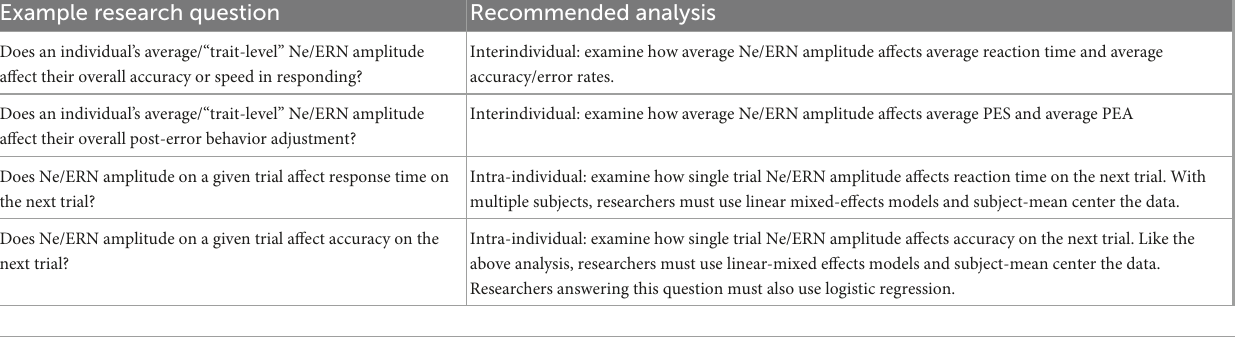
TABLE 3 How to choose Ne/ERN-behavior analyses based on research question. Example research question Recommended analysis